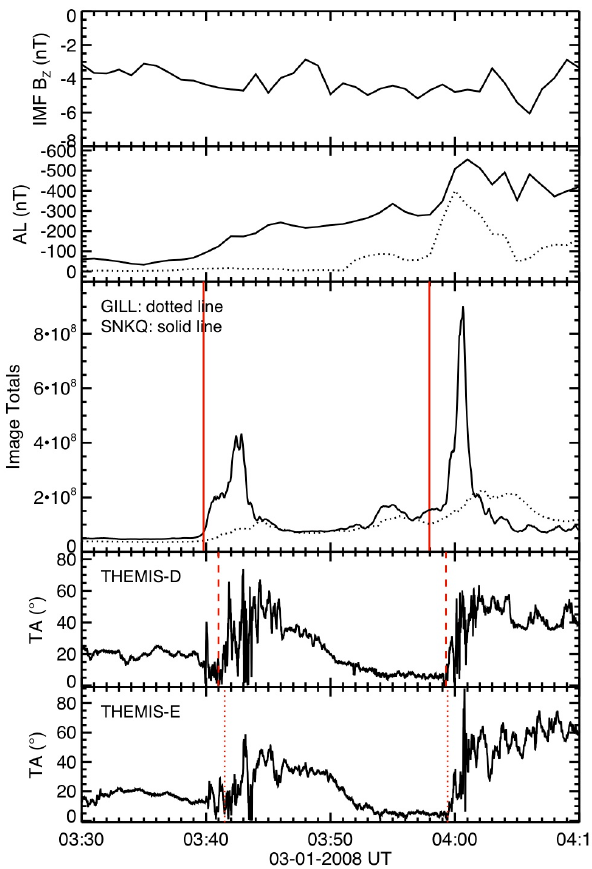
Fig. 3. Timing of key parameters during the two events: E-1 and E- 2. The IMF turned southward at ∼ 03:28UT. The Kyoto-AL index in solid curve is of 1-min resolution. The TH-AL index in dotted curve is of 3-s resolution. The image total plots at GILL (dotted curve) and SNKQ (solid curve) are the digital display of the ASI arrays of 3-s resolution (not shown). The timing of onset arc can be determined from the image total line plots to within the uncertainty of ± 3s, limited by the ASI resolution. 6 H / 6 P = 2. The observed AL index is seen to increase by a factor of ∼ 5 from ∼ 100 nT to ∼ 500 nT in the top panel of Fig. 1. The blockage parameter is estimated at α ∼ 1, accord- ing to Eq.